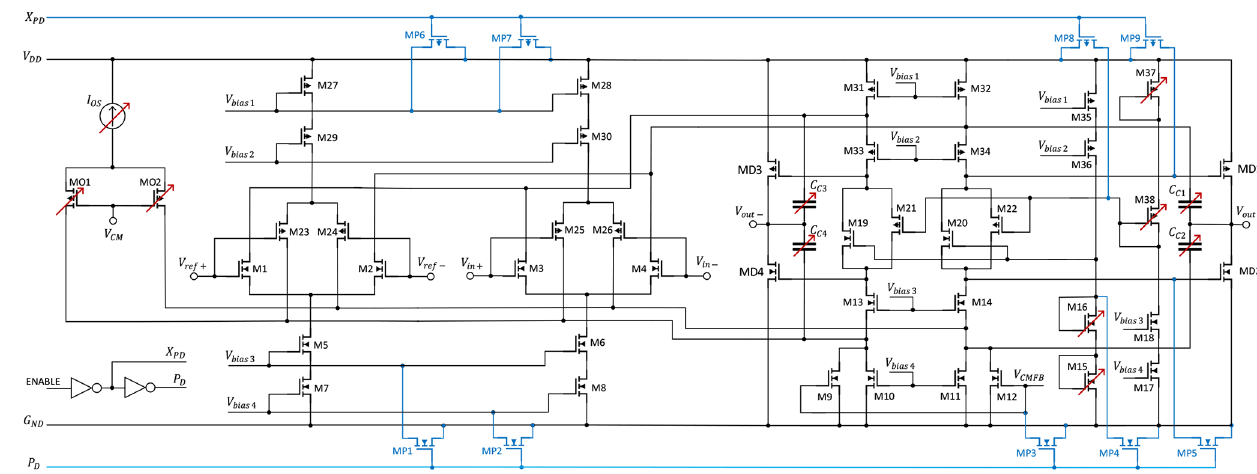
Figure 5. Transistor level realization of the fully differential CFIA. Table 1. Configurable circuit elements of CFIA.